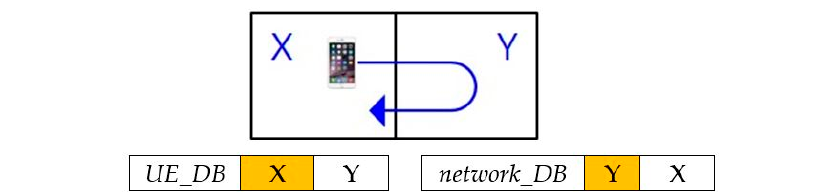
Figure 1. Zone-based registration with two zones.